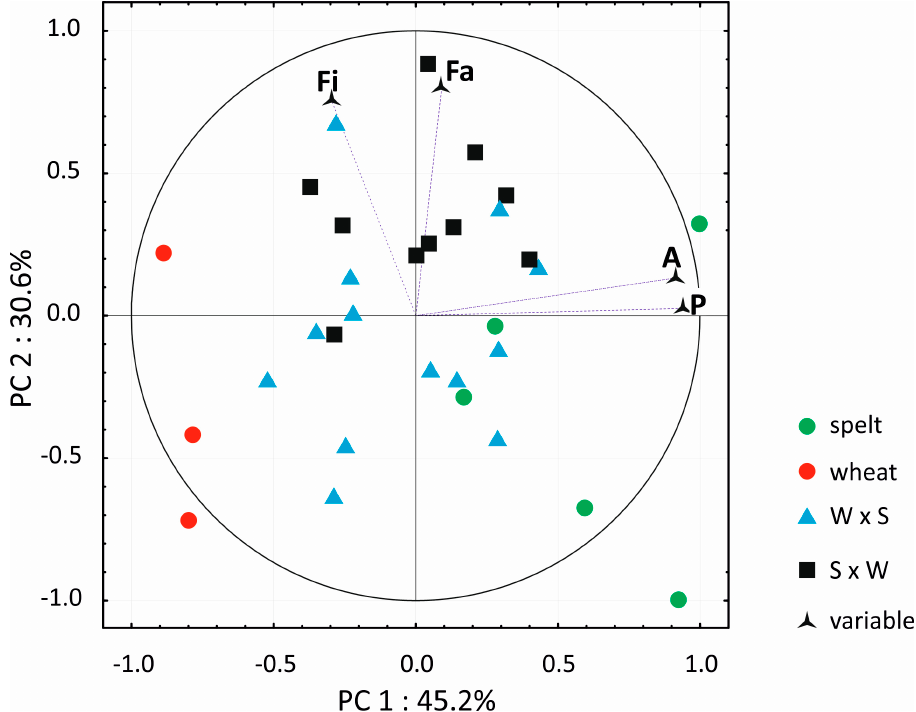
Figure 1. Biplot presenting principal component analysis (PCA) results for macronutrient content in the grain of thestudied cereals. Fi—fiber; Fa—fat; A—Ash; P—protein. W × S—wheat × spelt; S × W—spelt × wheat.